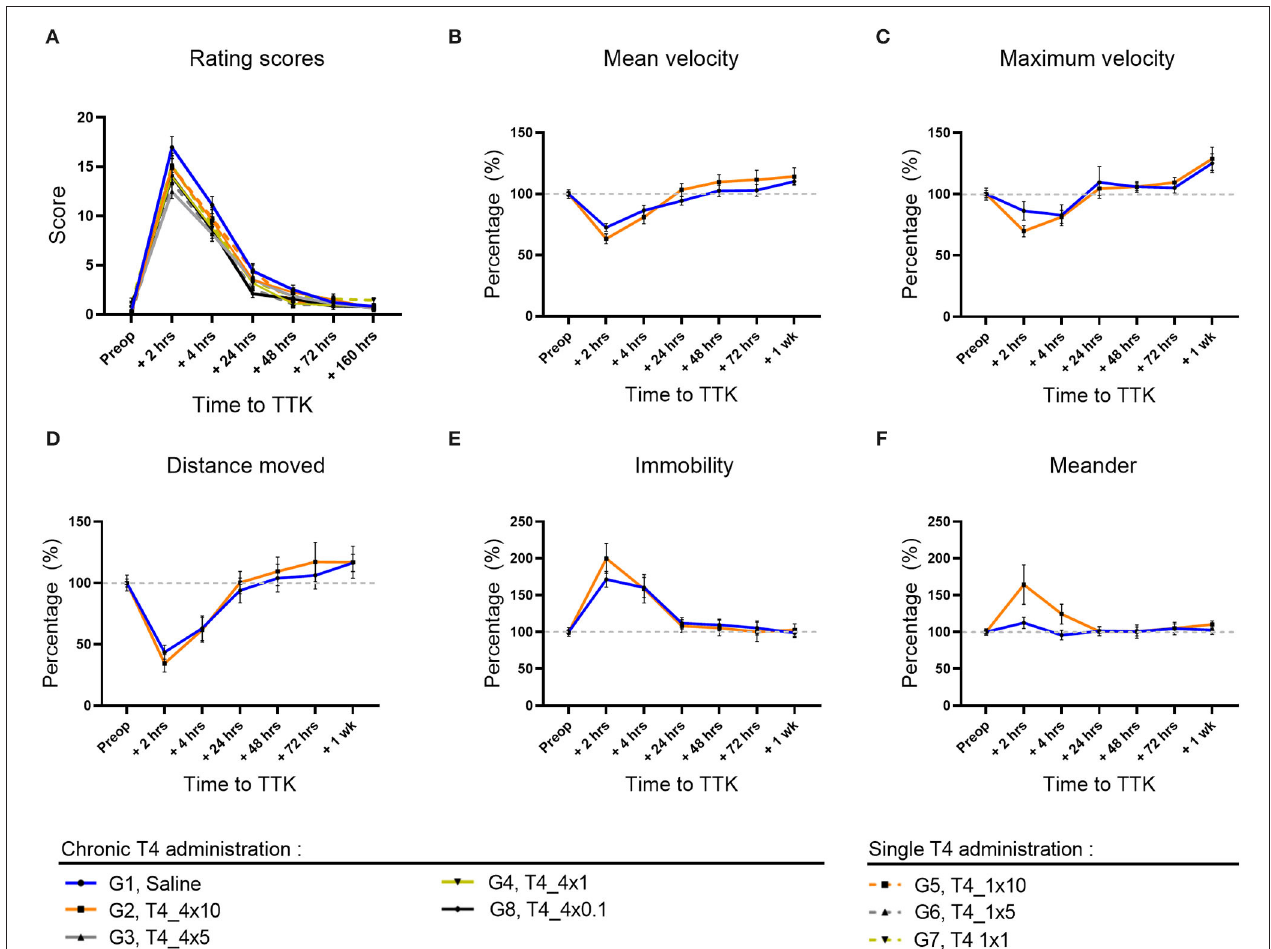
FIGURE 2 | Effect of T4 treatment in a rat model of excitotoxically-induced vestibulopathy: semi-quantitative assessment of the vestibular syndrome and global assessment of locomotor function. (A) The vestibular syndrome reaches its peak value at 2h post-TTK, having significant difference from preoperative values at 2h (16.95 vs.35, p < 0.0001), 4h (11.1 vs. 35, p < 0.0001), 24h (4.4 vs. 35, p < 0.0001) and 48h (2.5 vs. 35, p = 0.0002) after injury, before a gradual return to preoperative values at 72h and 7 days. (B–F) Effects of T4 treatment on the indicated motor behavior in vestibular defective rats at the different time points. T4